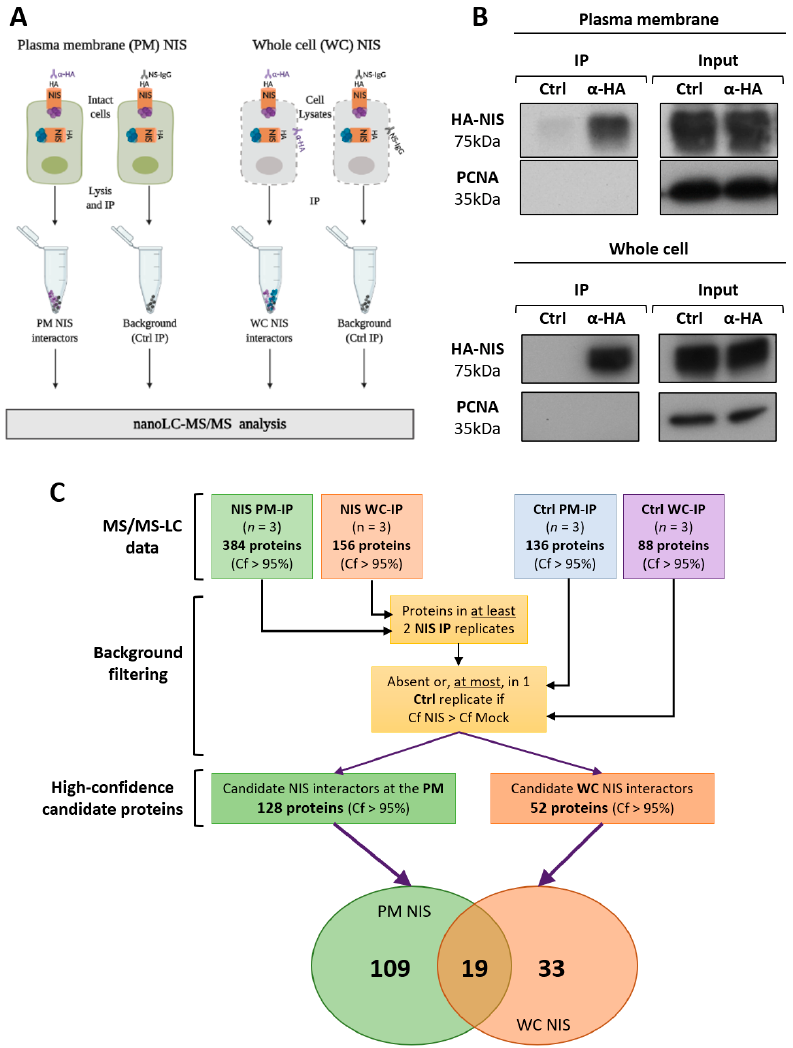
Figure 2. Sample preparation for the MS analysis . ( A ) Schematic representation of the protocols used to precipitate HA-NIS-containing complexes from the PM of intact cells, and to precipitate HA-NIS protein complexes from whole cell (WC) lysates (figure created with BioRender.com, accessed on 26 July 2021). Both WC- and PM-HA-NIS-containing complexes were selectively immunolabeled using a rabbit anti-HA antibody. Non-specific IgG (Ctrl) was used to control IP contaminants. ( B ) WC and PM immunoprecipitates were analyzed by Western blot to confirm IP robustness. The total (input) and IPed HA-NIS proteins were detected using a mouse anti-HA primary antibody. PCNA expression was used as the loading (input) and contamination control (IP). ( C ) Schematic representation of the pipeline used for the MS data analysis (see the text for details).